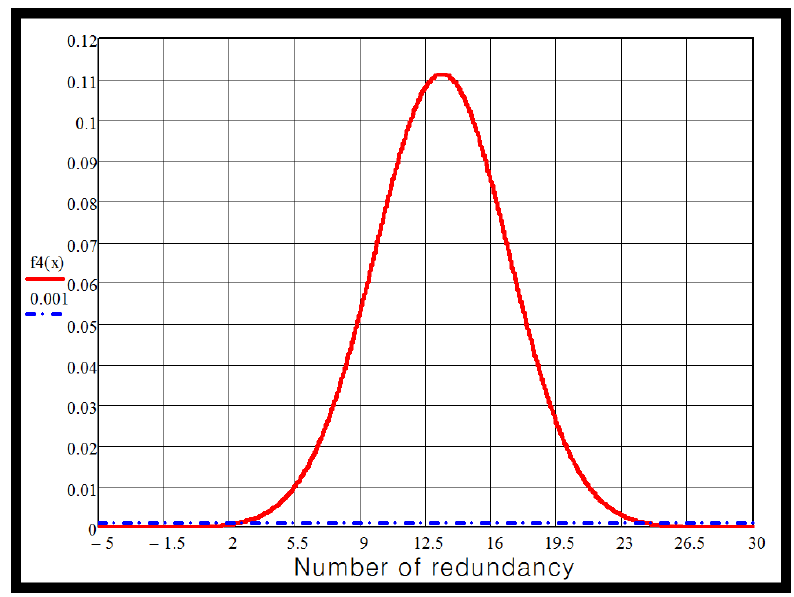
Figure 4. Unavailability function for the target system with 334 modules according to redundant modules